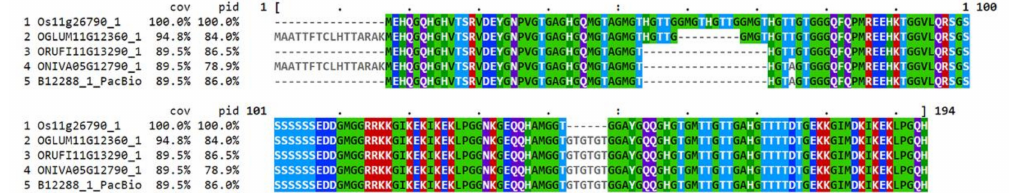
Figure 7. Multiple sequence alignment of five Oryza RAB21 dehydrin proteins. Os— Oryza sativa L. ssp. japonica , OGLUM— Oryza glumaepatula Steud., ORUF— Oryza rufipogon Gri ff ., ONIVA— Oryza